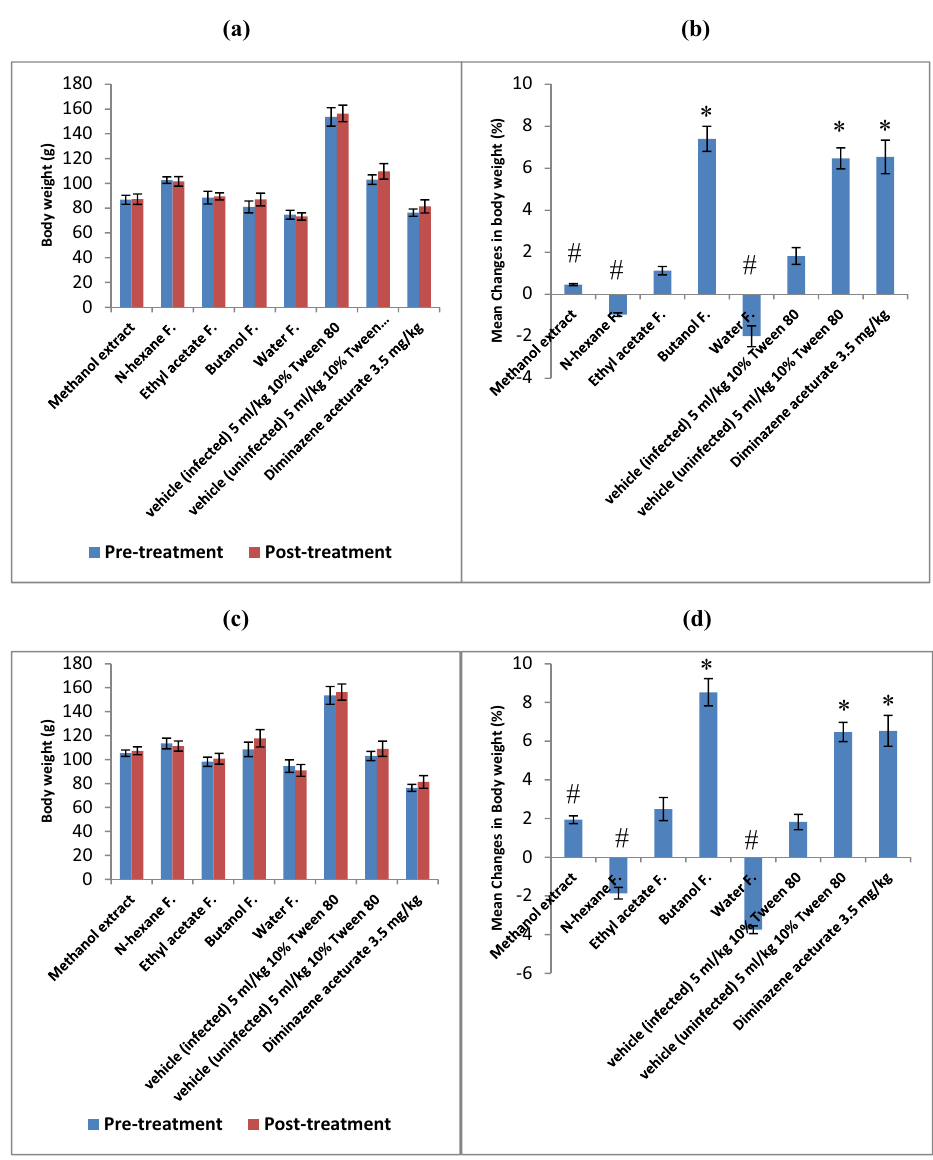
Figure 3: E ff ect of extract and fractions on BW of T. brucei brucei - infected animals. ( a ) 200 mg/kg extract and fraction e ff ect on BW; ( b ) 200 mg/kg extract and fraction e ff ect on mean changes in BW; ( c ) 400 mg/kg extract and fraction e ff ect on BW; and ( d ) 400 mg/kg extract and fraction e ff ect on mean changes in BW. * P < 0.05 compared to the vehicle - infected control group ( signi fi cant increase ) and # P < 0.05 compared to the vehicle - infected control group ( signi fi cant decrease )